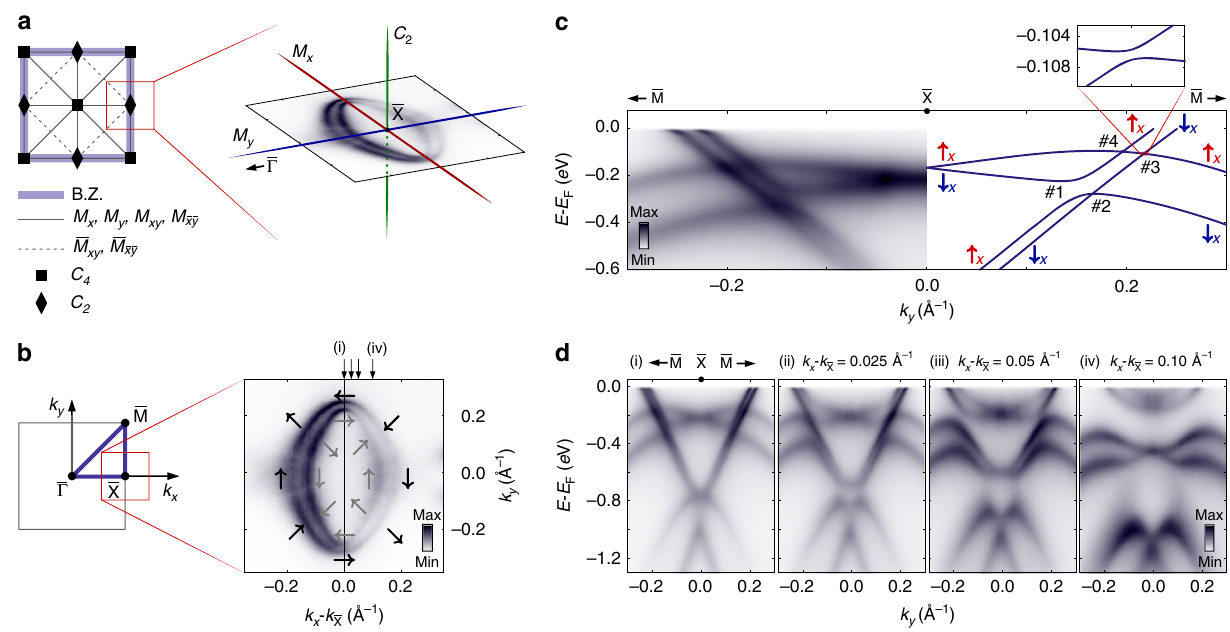
Fig. 2 Mirror-symmetry protected surface band crossings. a Symmetry elements of the p 4 mm layer group 50 , which applies to the surface projected Brillouin zone and the surface unit cell of NbGeSb. The inset shows the relevant symmetries at the X point overlaid on the surface state Fermi surfaces measured in the vicinity of this point. b The resulting spin textures of these Fermi surfaces are shown schematically by arrows. c High-resolution ARPES measurements (left) and DFT calculations (right) in the vicinity of the surface state crossings along X (cid:3) M . The four band crossings are numbered and spin polarisation is again indicated by arrows. Inset is a close-up of crossing #3, showing a small hybridisation gap of ca. 1 m e V. d ARPES dispersions measured off the X (cid:3) M line, along the cuts indicated in b , demonstrating the evolution of the crossing structure away from the M x mirror line at the Brillouin zone